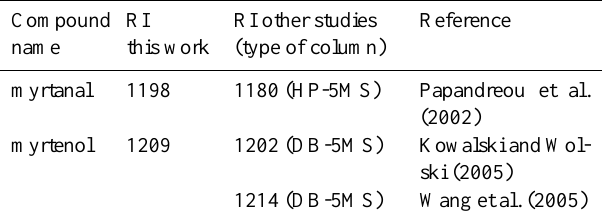
Table 3. Comparison of determined linear retention indices of the identified products with literature